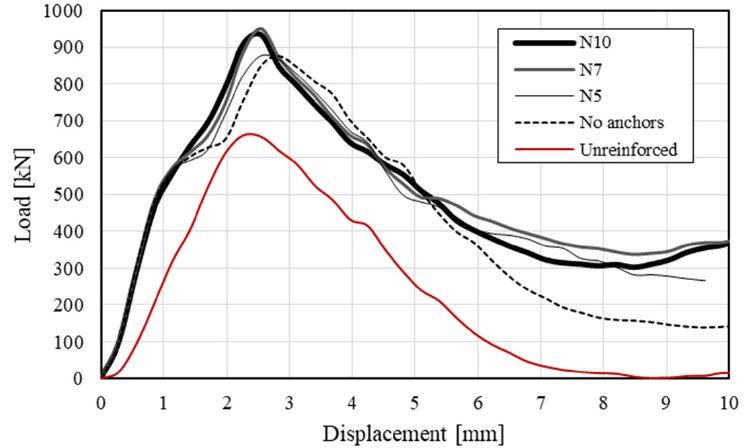
Figure 21. Load–displacement curves for different number of anchors.